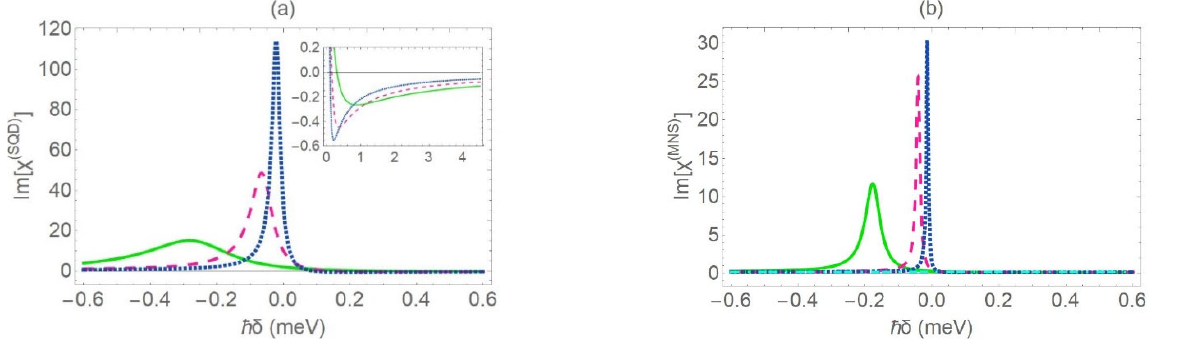
Figure 7. The linear absorption spectra for the SQD ( a ) and the MNS ( b ), for different values of the center-to-center distance (green solid curve: R = 11.5 nm, pink dashed curve: 13.5 nm, blue dotted curve: 15.5 nm and turquoise dashed-dotted curve: 100 nm). Captions ( a ) and ( b ) correspond to the cases in which the inner radius of the MNS r 1 is equal to 2 nm and 7 nm, respectively. The dielectric constant of the core ε c is set equal to 7.5 and the rest physical parameters take the same values as in Figure 3.